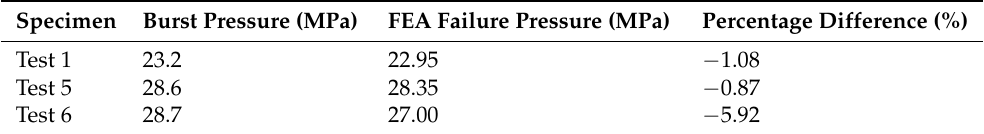
Table 7. Corrosion defect parameters for full scale burst tests by Benjamin et al. [51].